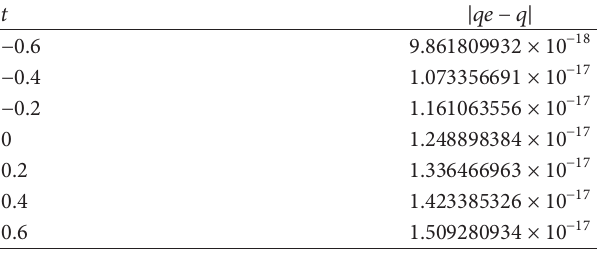
Table 5: The HAM results for 𝑞 (𝑥,𝑦,𝑡) in comparison with the analytical solution with initial conditions (5).